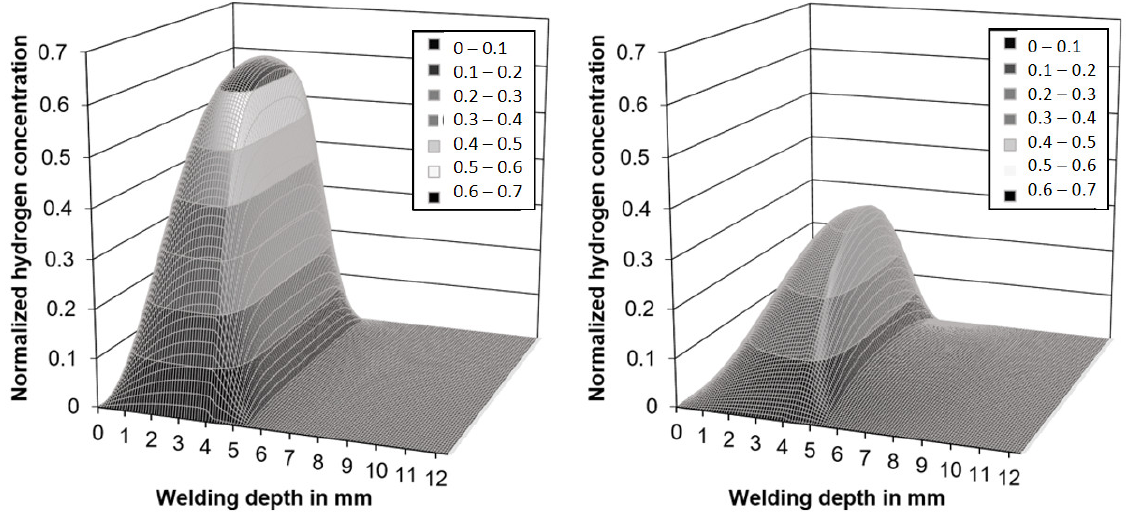
Figure 5. Calculated hydrogen distribution in the simplified weld model, after 300 s without ( left ) and with induction heating ( right ).